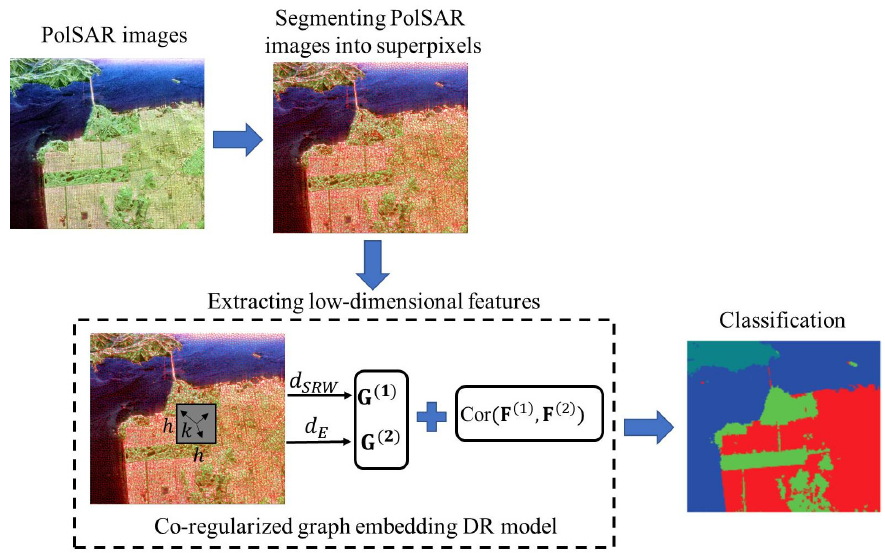
Figure 1. The whole process based on co-regularized graph embedding for PolSAR image